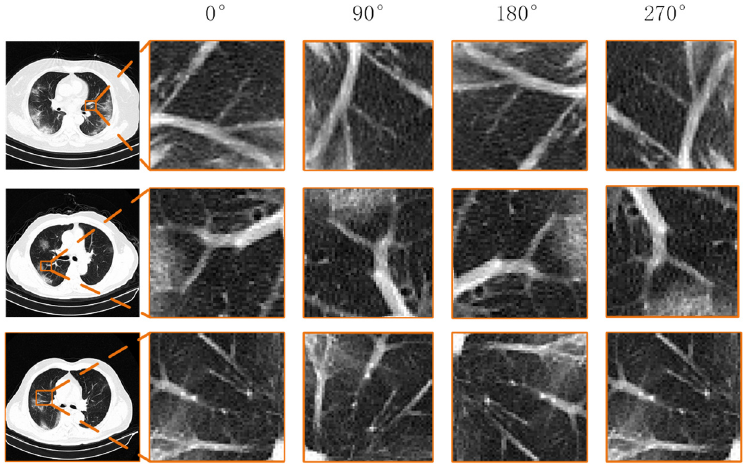
Figure 1. Example of blood vessel orientation and rotation in CT images of COVID-19 patients. In summary, our main contributions are three-fold.